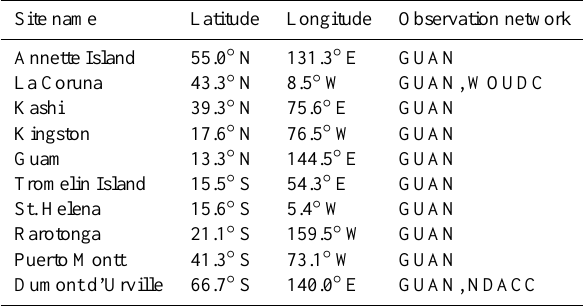
Table 2. Proposed measurement sites for the detection of 21st cen- tury temperature trends at the middle